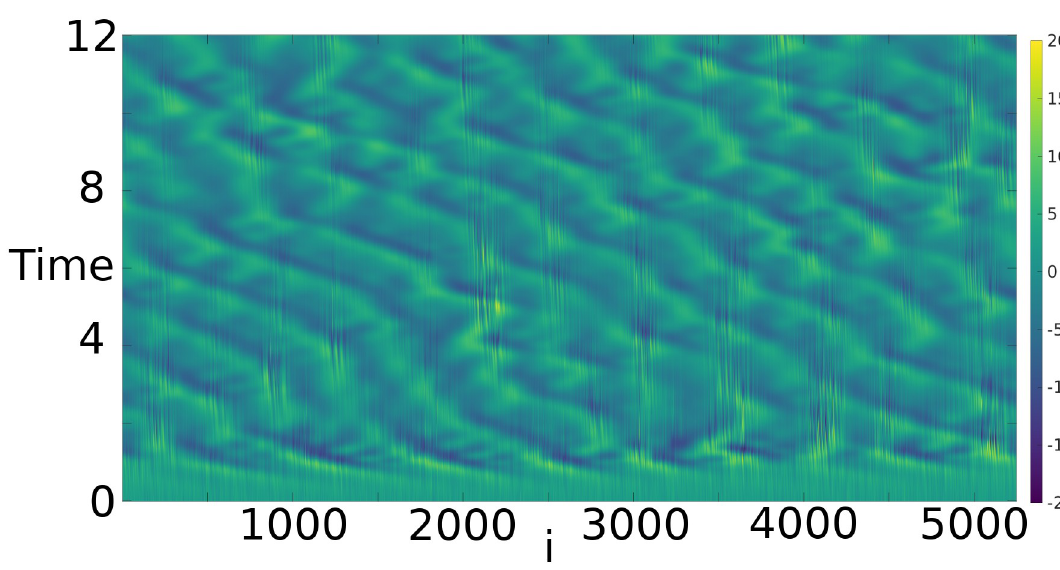
Fig 3. A simulation of the two-scale Lorenz-‘96 model initialized at t = 0 with a sample from a standardnormal distribution.